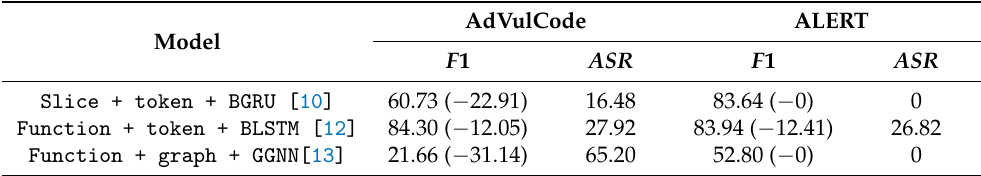
Table 4. Comparing with the existing attack method on the NVD and SARD datasets (unit: %)